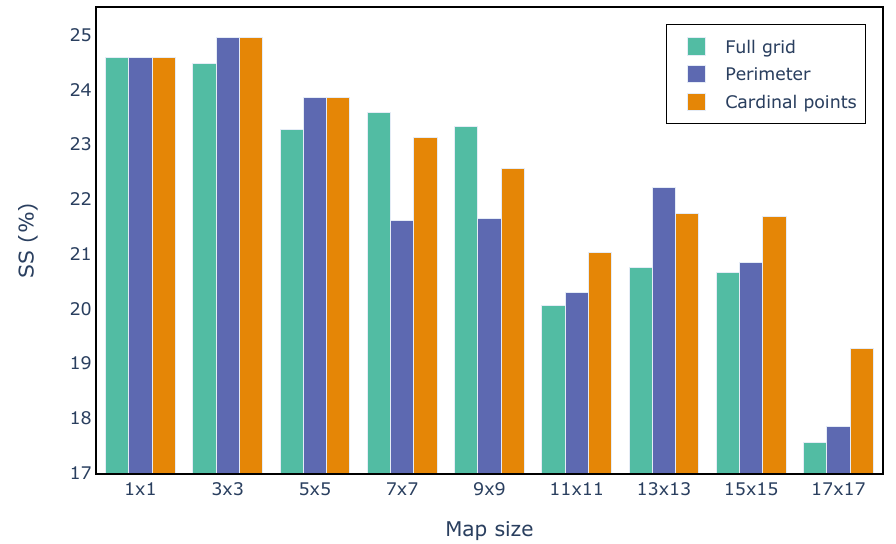
Figure 10. The bar chart shows the SS achieved by training separate networks, one for each map size, from 1 × 1 to 17 × 17. In particular, green (left) bars refer to the results obtained by training the networks on full feature maps, purple (central) on perimetric features, and orange (right) on cardinal point